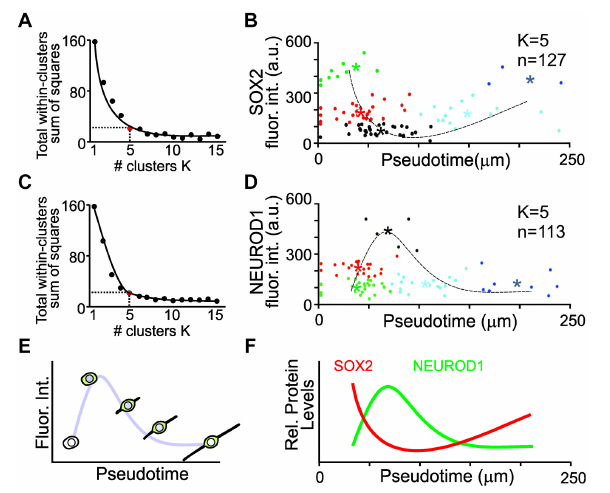
FIGURE 5 | K-means clustering and pseudotemporal analysis of iMOP-derived neurons. (A) Elbow test to identify the number of K clusters for SOX2 intensity measurements. Red point denotes the minimal number of clusters that represents the least variance in the data. (B) Clustering of cells ( n = 127) into clusters ( K = 5). Asterisks denote mean fluorescence intensity of SOX2 for each cluster and the dotted line represents curve fit for the measurements. (C) Elbow test for NEUROD1 intensity measurements. (D) Clustering of cells ( n = 113) into distinct populations ( K = 5). Asterisks represent mean fluorescence intensity of NEUROD1 for each cluster with the curve fit represented by the dotted line. (E) Curve fit of the mean fluorescence intensity in pseudotemporal ordered cells represents the dynamics of protein expression. Measurements of cells were obtained from a total of n = 5 individual experiments. (F) Summary of SOX2 and NEUROD1 protein expression dynamics after pseudotime analysis.